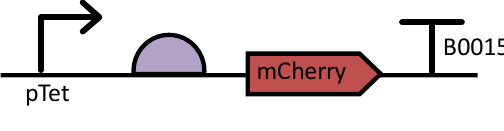
Figure 27: Examples of labels on